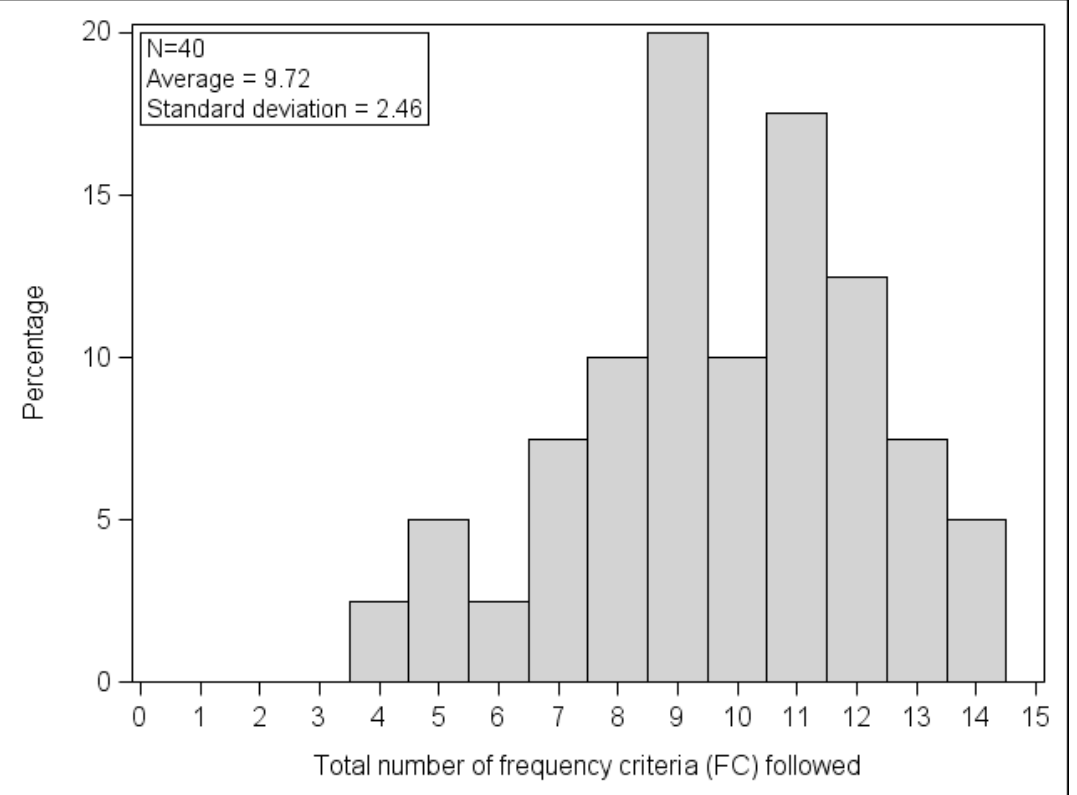
Figure 2. Distribution of the number of frequency criteria complied with in the observed series of meals ( N = 40 series).